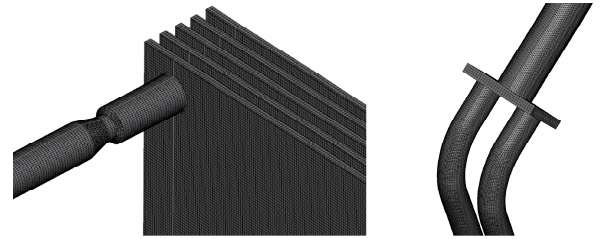
Figure 2. The unstructured Cartesian grid on stationary components: the outlet section of the regenerator and the CFM inlet section.